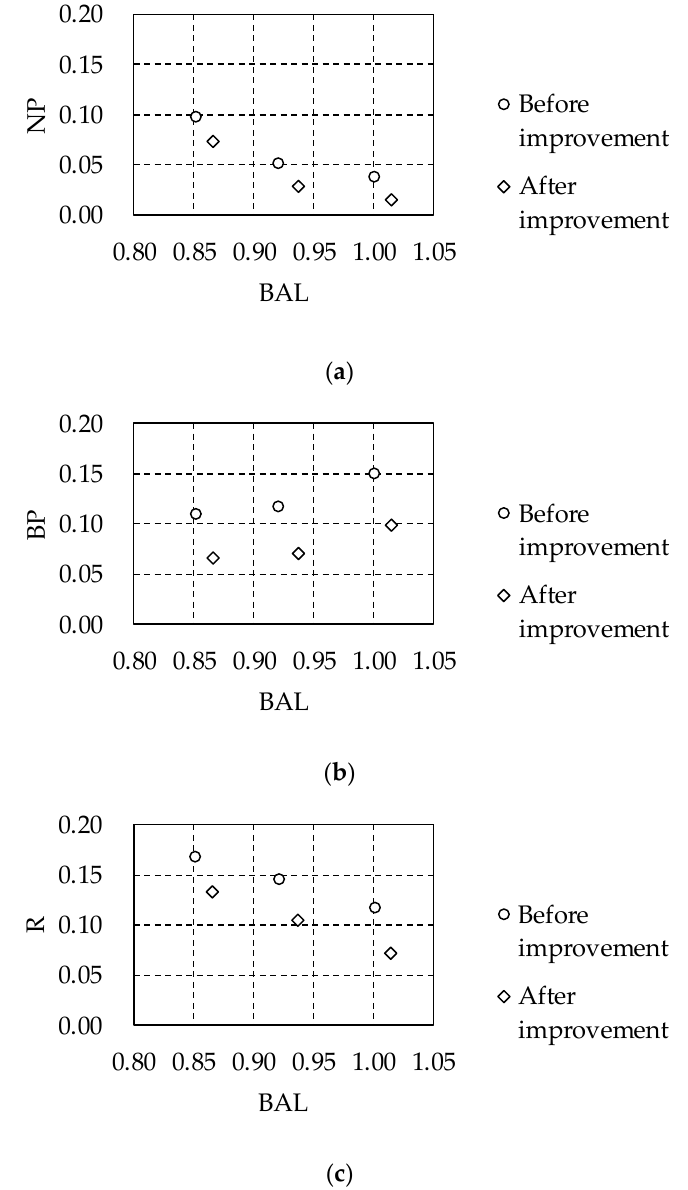
Figure 11. Relationship between balance ratio (BAL) and each air-flow ratio: ( a ) balance ratio (BAL) and negative-pressure ratio (NP); ( b ) balance ratio (BAL) and bypass ratio (BP); and ( c ) balance ratio (BAL) and recirculation ratio (R).